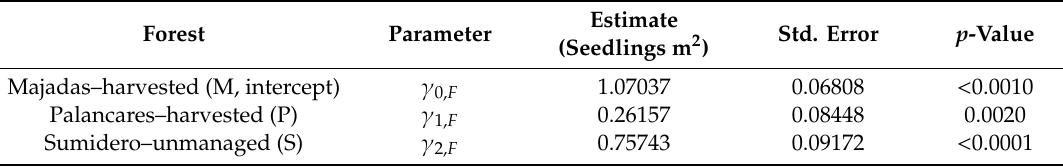
Table 6. Parameter values of Equation (4) (count part of the zero-inflated model), estimates, standard errors and p -values to estimate the number of recruits (forest effect) in Spanish black pine forests of Cuenca Mountains (Spain).